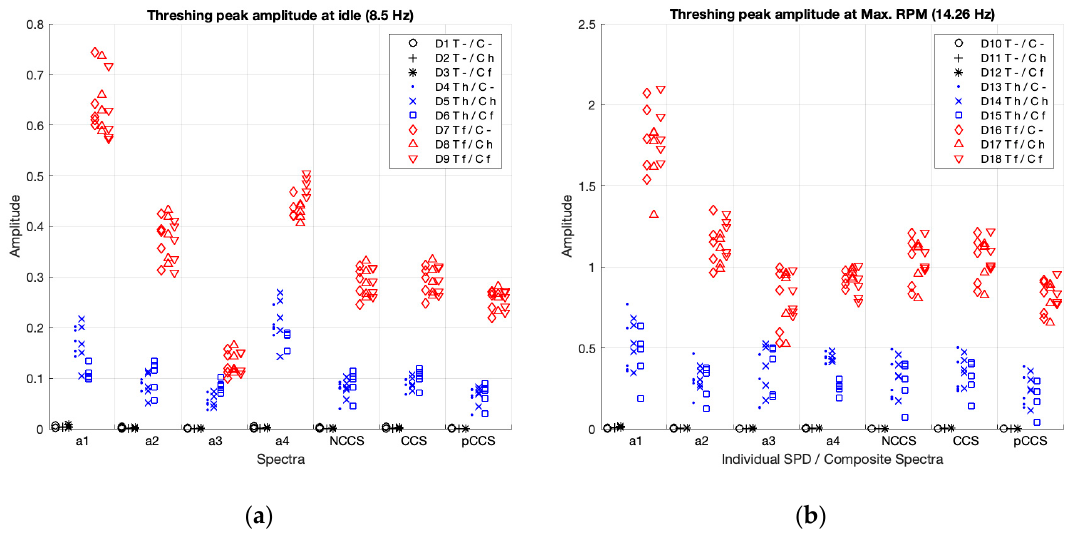
Figure 7. Peak amplitudes for the thresher in the individual spectra (a1–4) and the non-coherent (nCCS), coherent (CCS), and poly-coherent (pCCS) composite spectra, at idle ( a ), and at maximum RPM ( b ). In blue, the balanced cases; in red, the unbalanced cases; and, in black, the cases where the components are deactivated. Table 3. Sample description and statistical comparison of the peak amplitudes of the thresher, detected in individual spectra (a1–4), and the non-coherent (nCCS), coherent (CCS), and poly- coherent (pCCS) composite spectra, under different working conditions (deactivated, balanced and non-balanced) and at different speeds (at idle and at max. RPM).